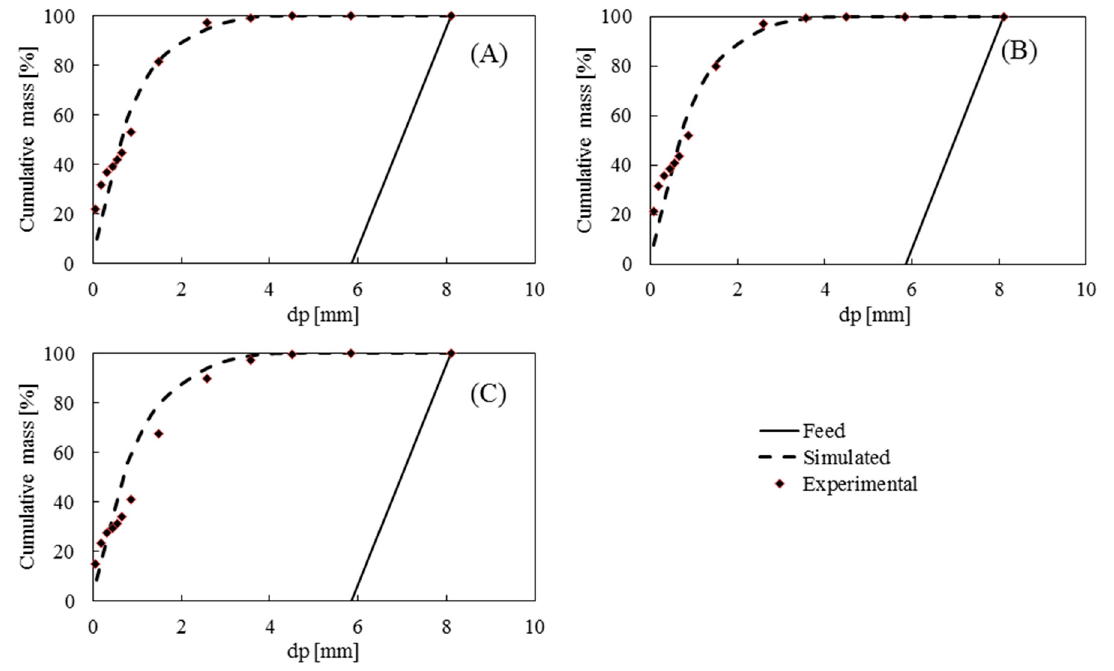
Figure 16. Feed, experimental and predicted curves of the altered granite showing the effect of varying the specific pressing force. ( A ) PP-1; ( B ) PP-2 and ( C ) PP-3.